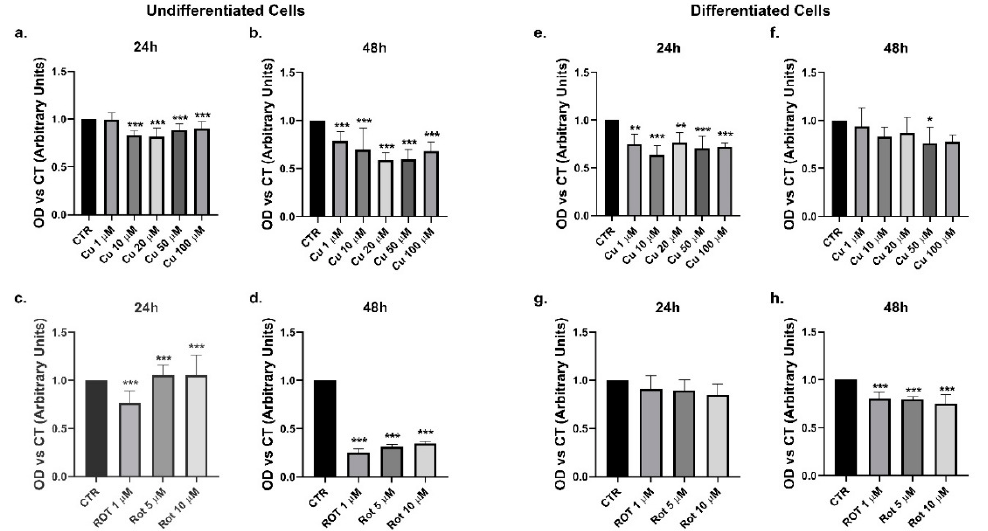
Figure 2. Effects of copper on cell viability (relative MTT assay). Undifferentiated SHSY5Y cells were treated with the indicated concentrations of copper or rotenone for 24 h ( a , c ) and 48 h ( b , d ). The same treatments were performed in differentiated cells, also in this case for 24 h ( e – g ) and 48 h ( f – h ). The results are presented as means ± SD of seven replicates; values were compared with untreated cells (CTR) by one-way ANOVA following Tukey test * p < 0.0332 ** p < 0.0021 *** p < 0.0002, compared to untreated cells (CTR).